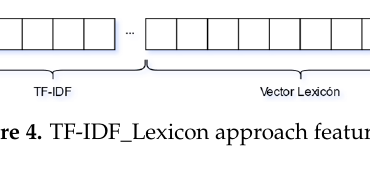
Figure 3. TF-IDF_Lexicon approach process.